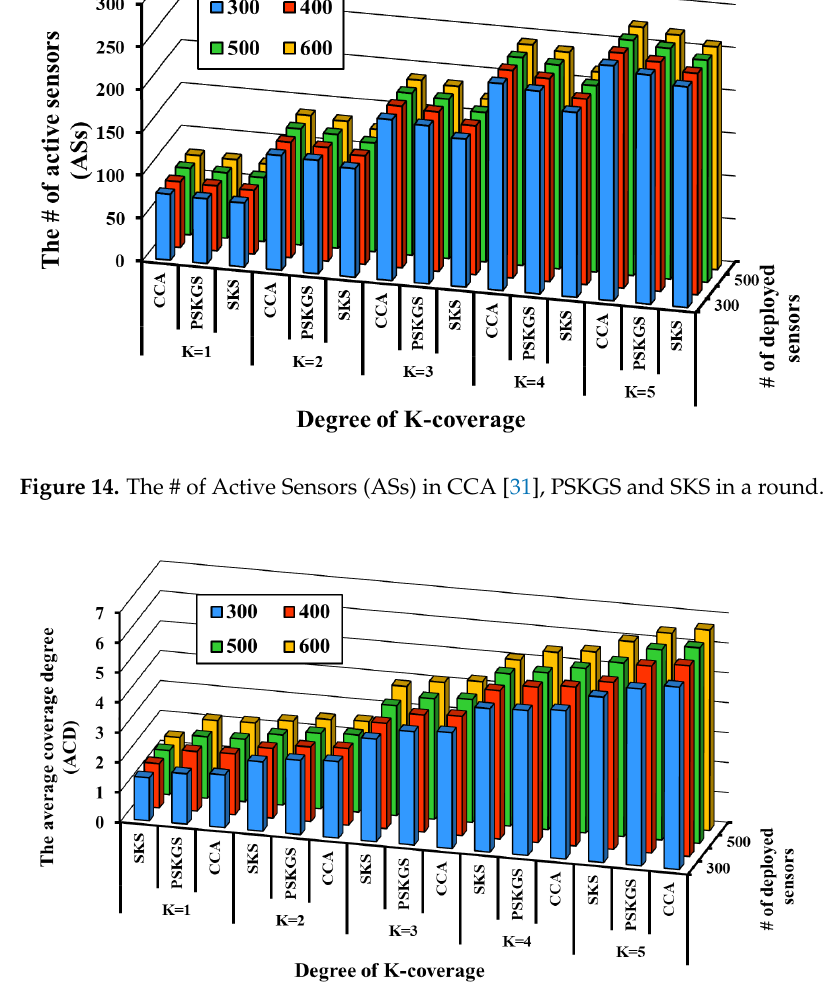
Figure 15. The Average Coverage Degree (ACD) of SKS, PSKGS and CCA [31] in a